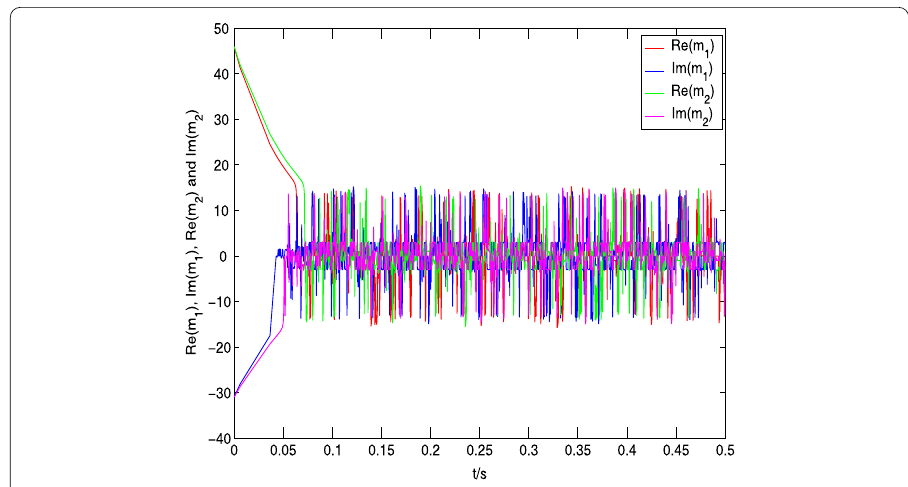
Figure 5 Time responses of the real and imaginary parts of the designed controllers in Example 2